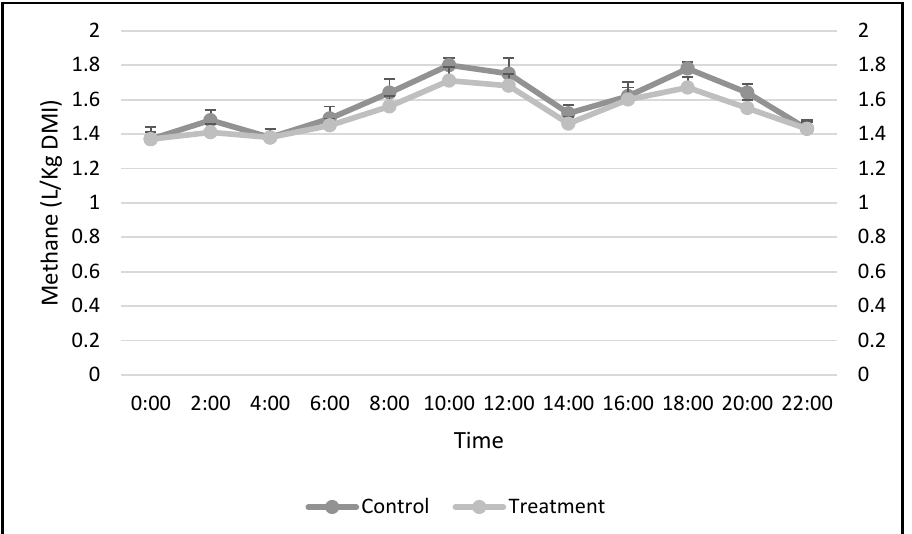
Figure 1. Changing trend of the methane production of goats in a day. The methane was measured using the LumaSense Photoacoustic Gas-Monitor INNOVA 1412i and Multi-Sampling 1309 gas monitor systems. The measurement was carried out for 48 h, however same trend was observed for both days. Error bars represent the SEM (standard error mean).